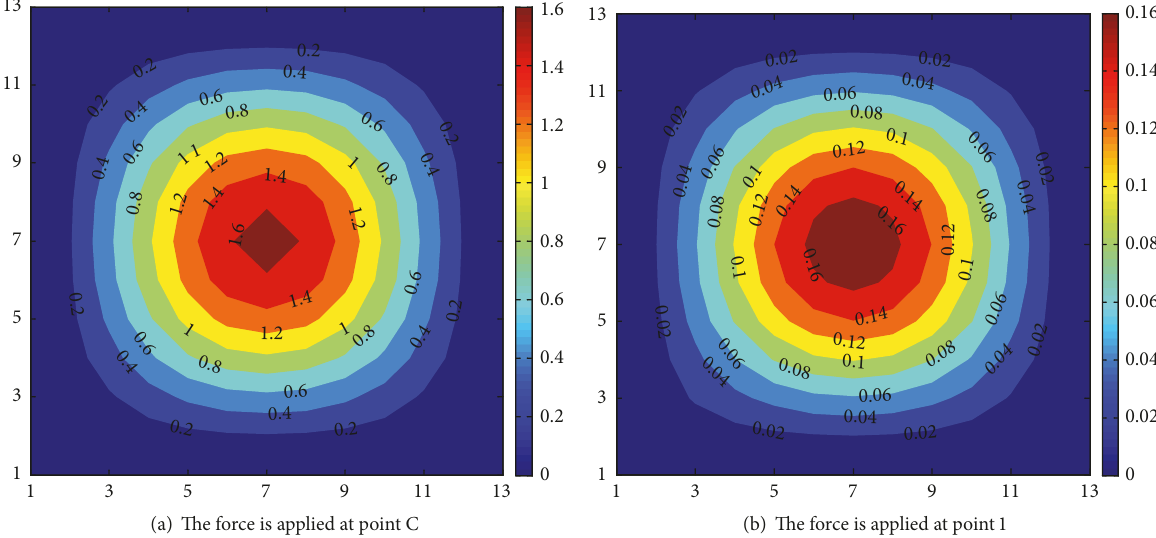
Figure 20: The vibration normal velocity in the full coverage plate with CLD materials for first